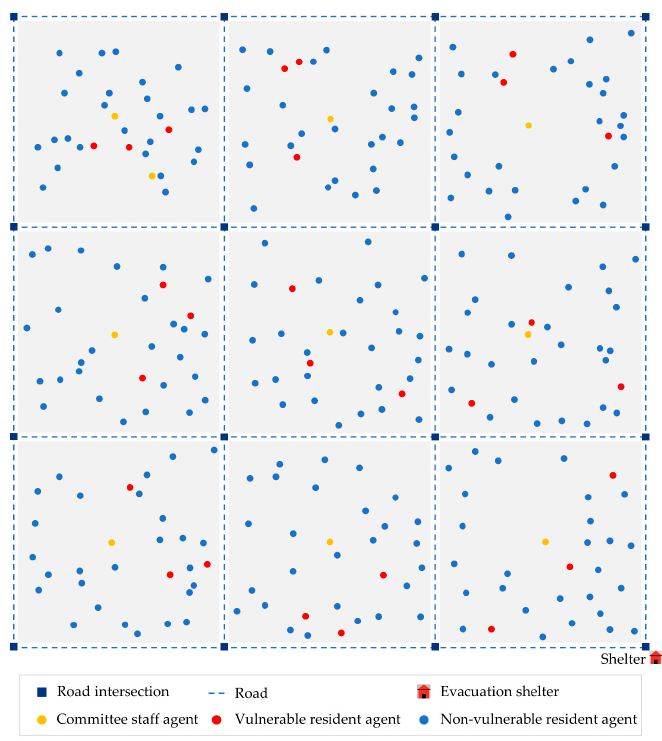
Figure 4. Illustration of the synthetic community. The community consisted of a road network, nine community grids, one shelter and a number of community residents committee sta ff agents and resident